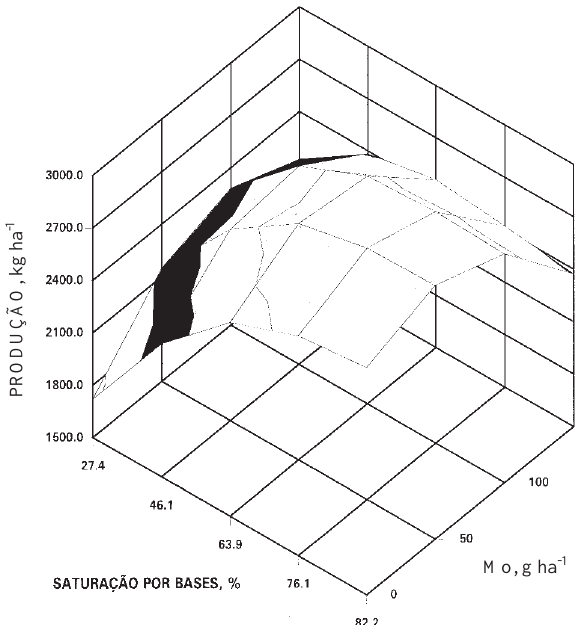
Figura 1. Superfície de resposta da soja (IAC-11) à correção da acidez do solo e doses de molibdênio num Podzólico Vermelho-Amarelo da Estação Experimental de Mococa do